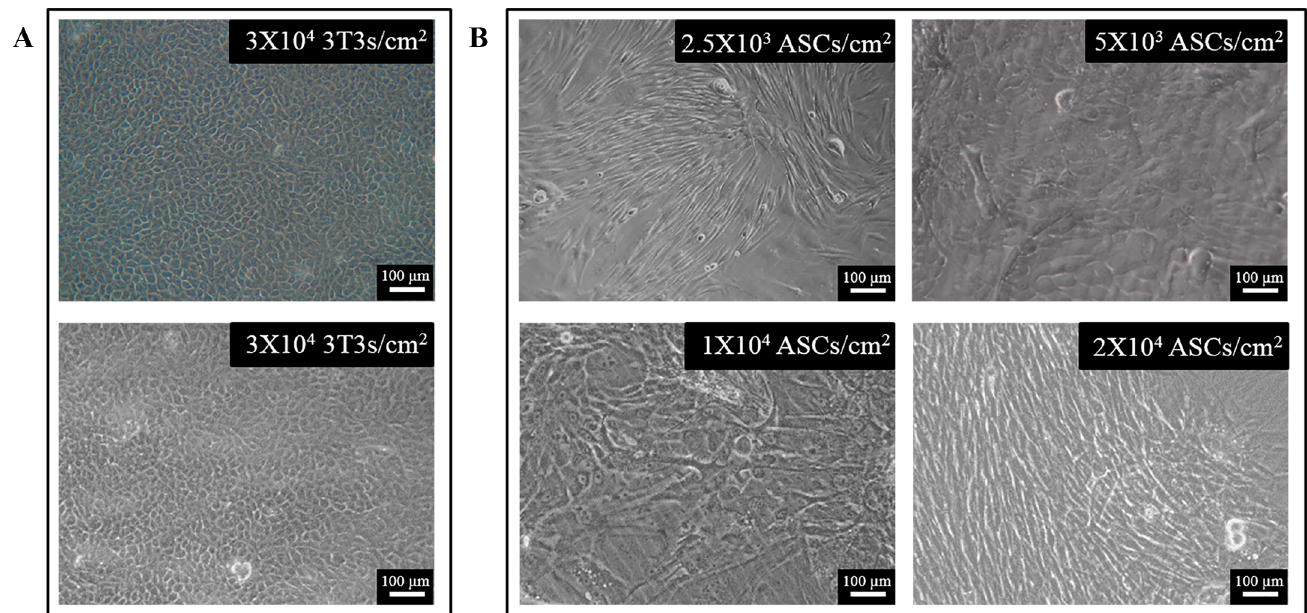
Fig 2. Optimization of the cell density of ASCs as feeder cells. (A) Representative morphologyof LSCs cultured on 3 x 10 4 3T3 cells/cm 2 for 2 weeks. (B) Representative morphology of LSCs cultured on gradientdensitiesof ASCs for 2 weeks. The density of feeder cells was labeledat the top right corner of each image. Scale bar = 100 μ m.